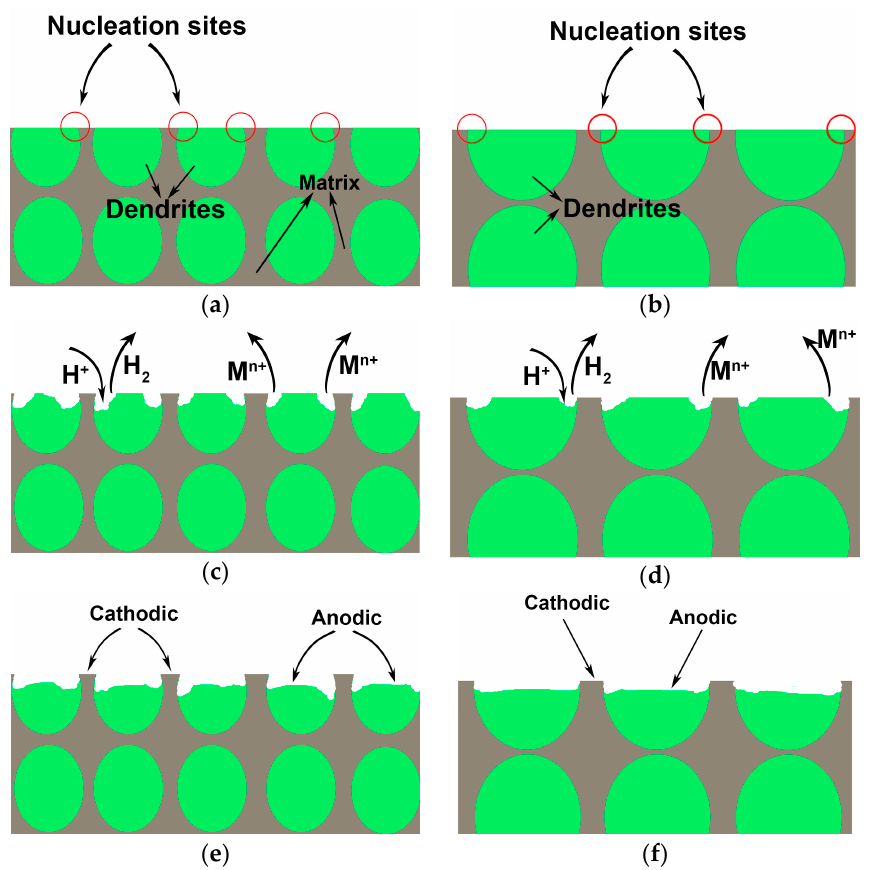
Figure 7. Schematic illustration for comparing the different corrosion processes in small and large diameter rods: ( a , b ) are schematic diagrams before corrosion, ( c , d ) are corrosion process, ( e , f ) are schematic diagrams after corrosion.